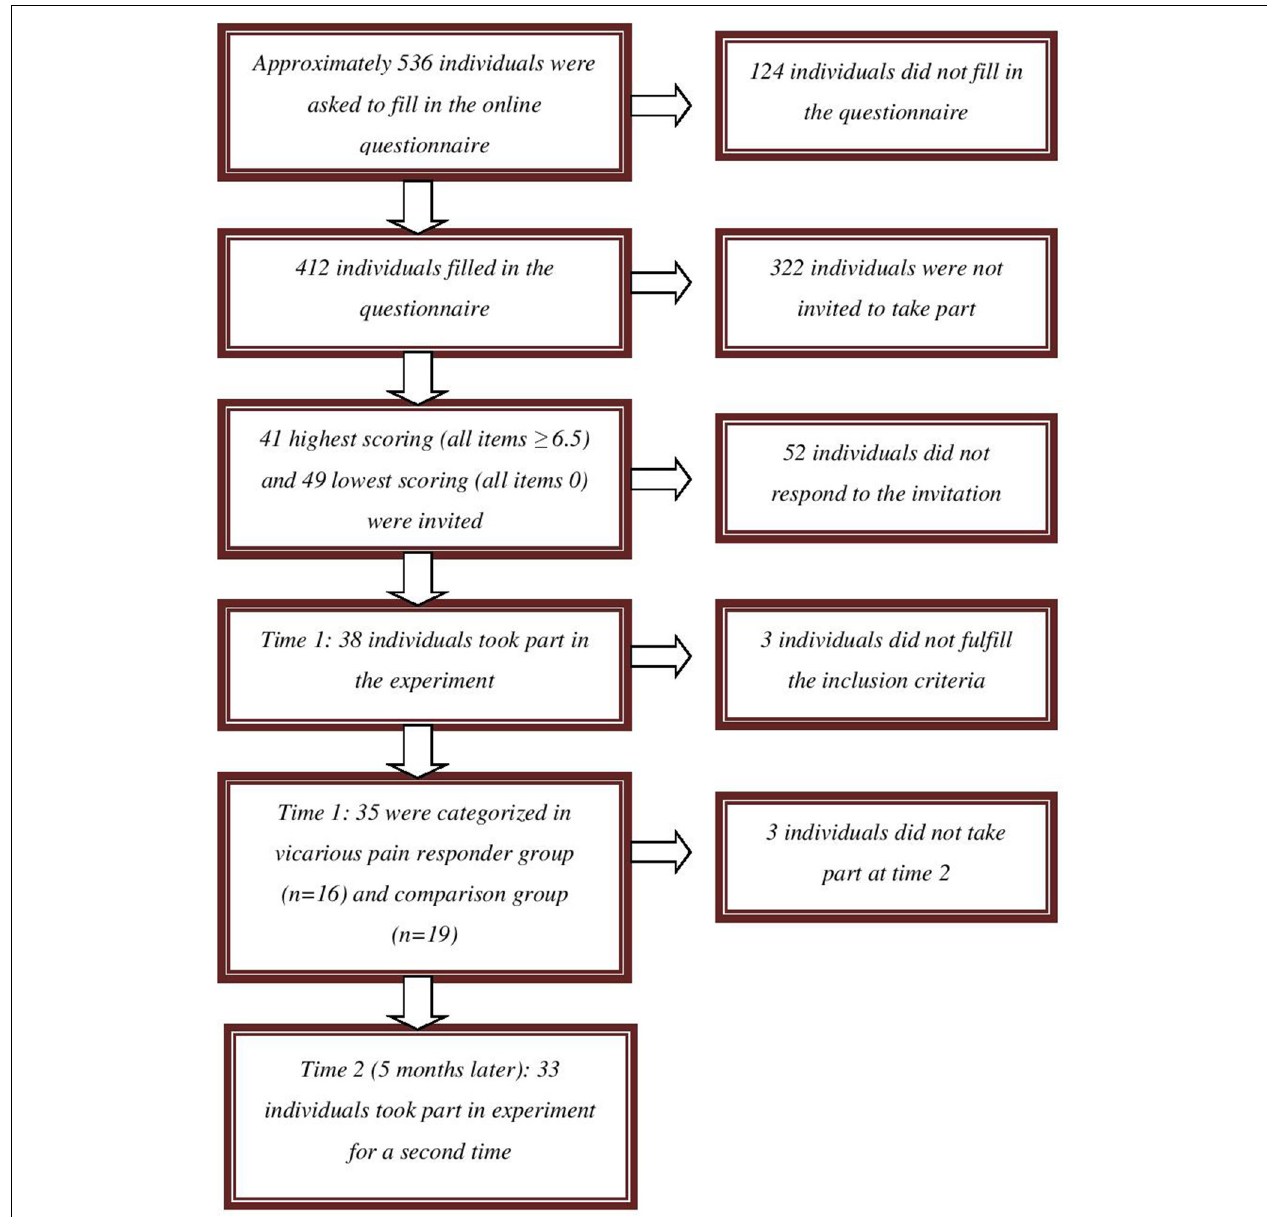
FIGURE 1 | Flow chart of recruitment of vicarious pain responders and